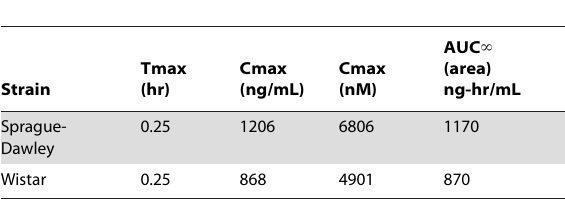
Table 1. Pharmacokinetic parameters for male Sprague Dawley (N=3) and Wistar (N= 3) rats following subcutaneous administration of 5.6 mg/kg